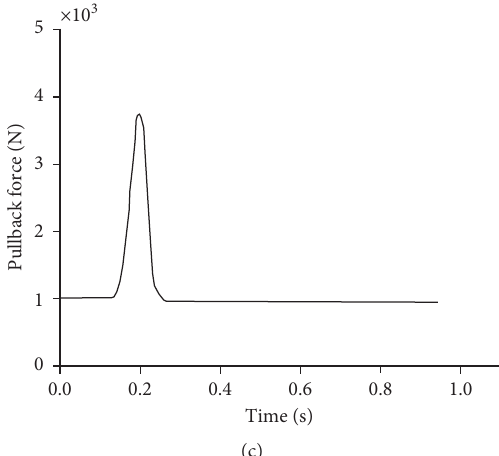
Figure 9: Variation curves of pullback forces under different radiuses of curvature.